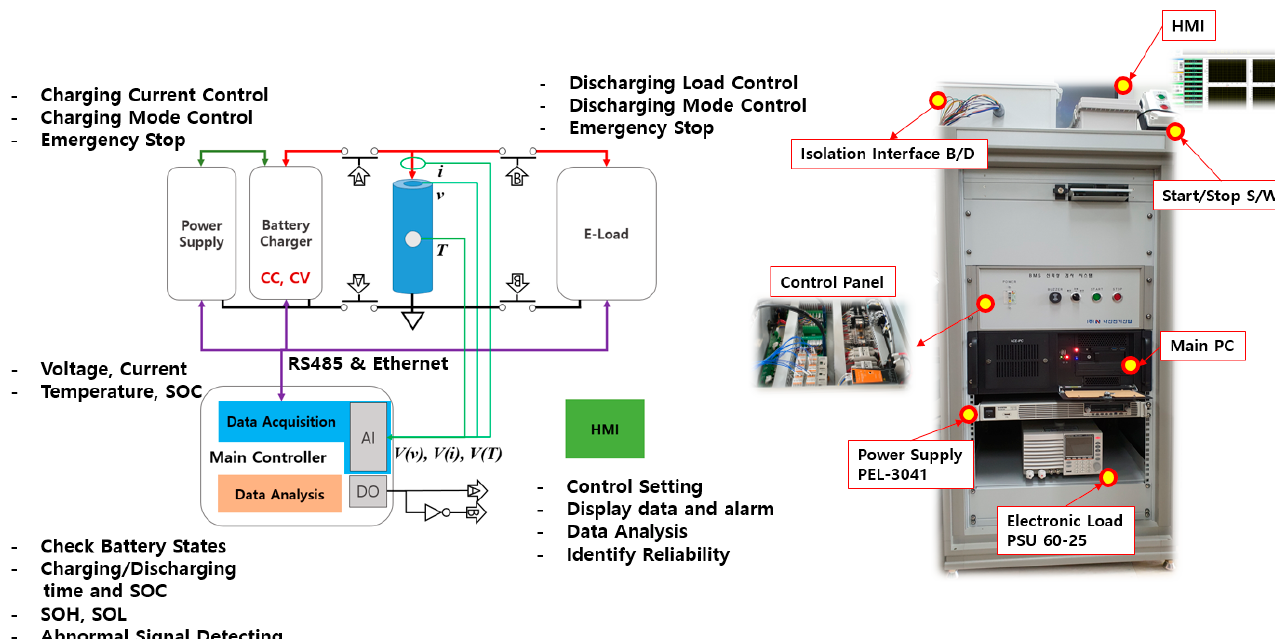
Figure 1. Configuration of the battery cycle test system.